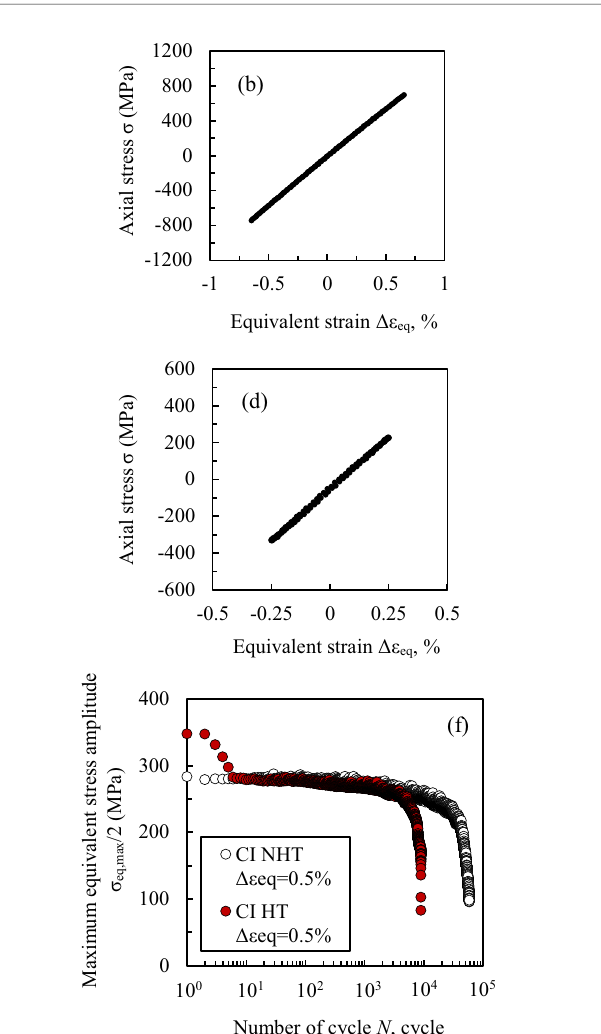
1.3% of a PP HT and b PP NHT and Δε eq = 0.5% of f CI =